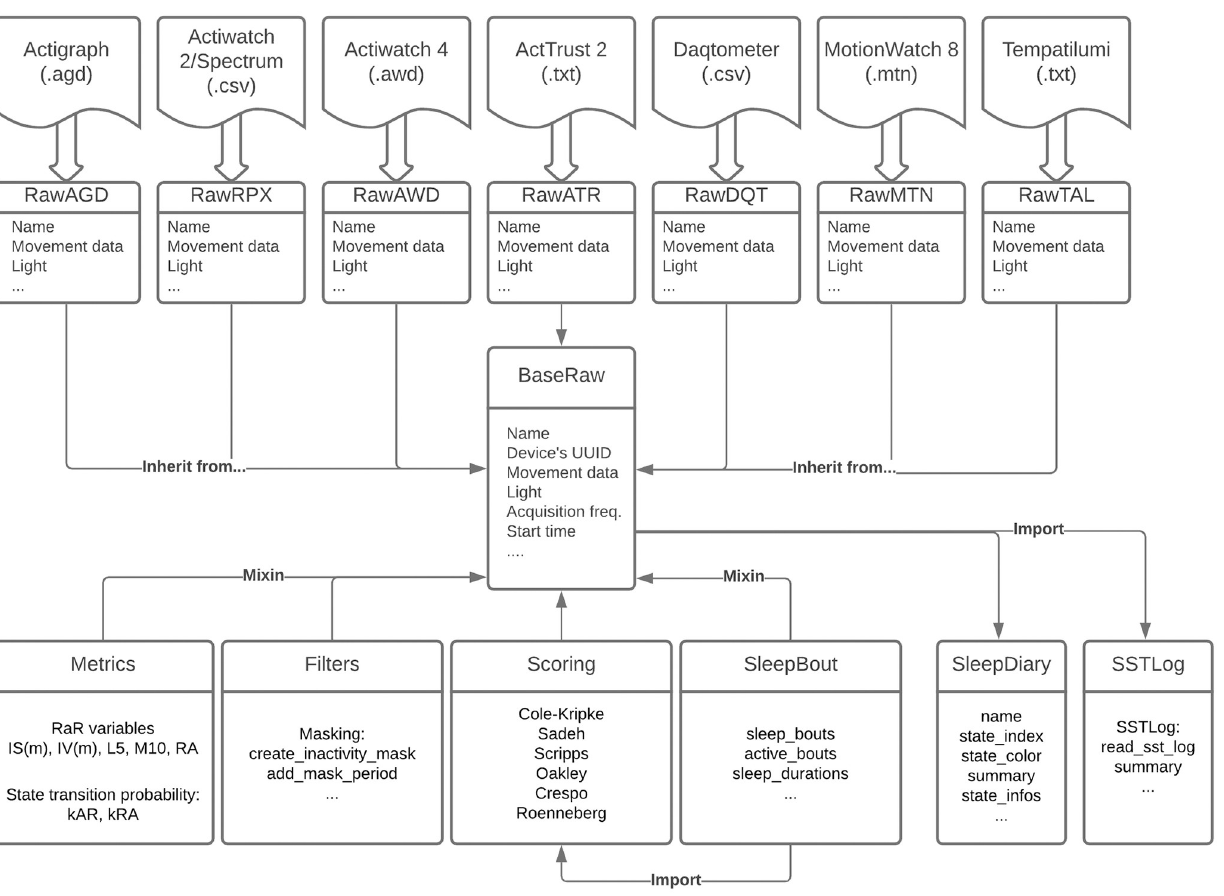
Fig 1. Diagram of the code